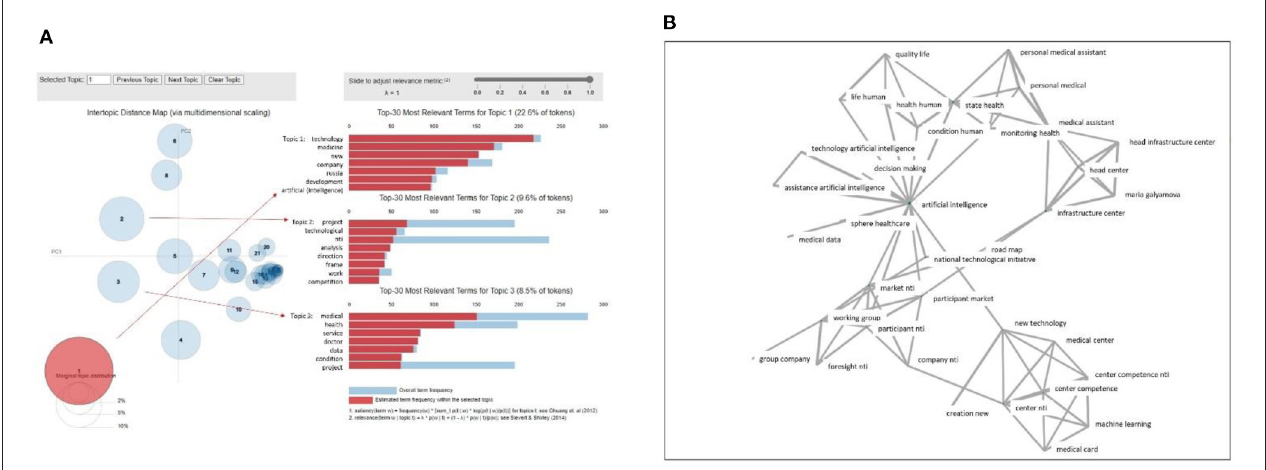
FIGURE 5 | NTI Facebook accounts (2020–2021): LDA-produced clusters (A) and keyphrases visualization with vertex frequency p > 8 (B)